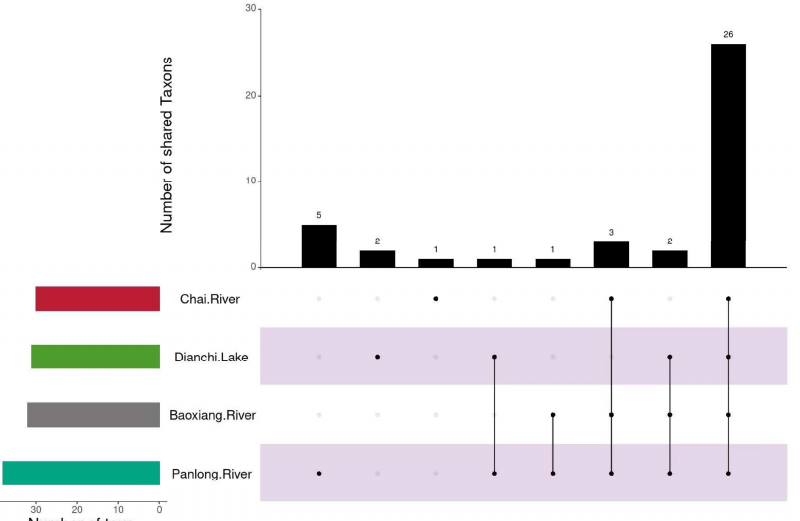
Figure 2. Upset plot with the number of shared taxa among habitats and the total number of taxa detected.